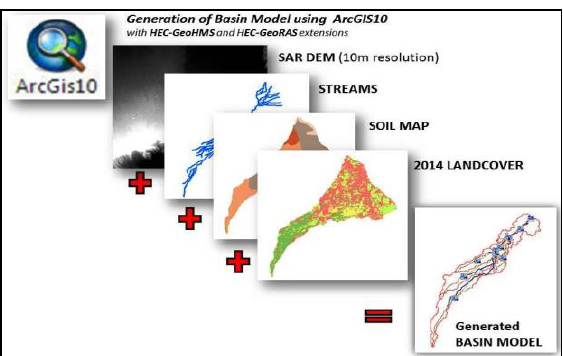
Figure 6. Basin model